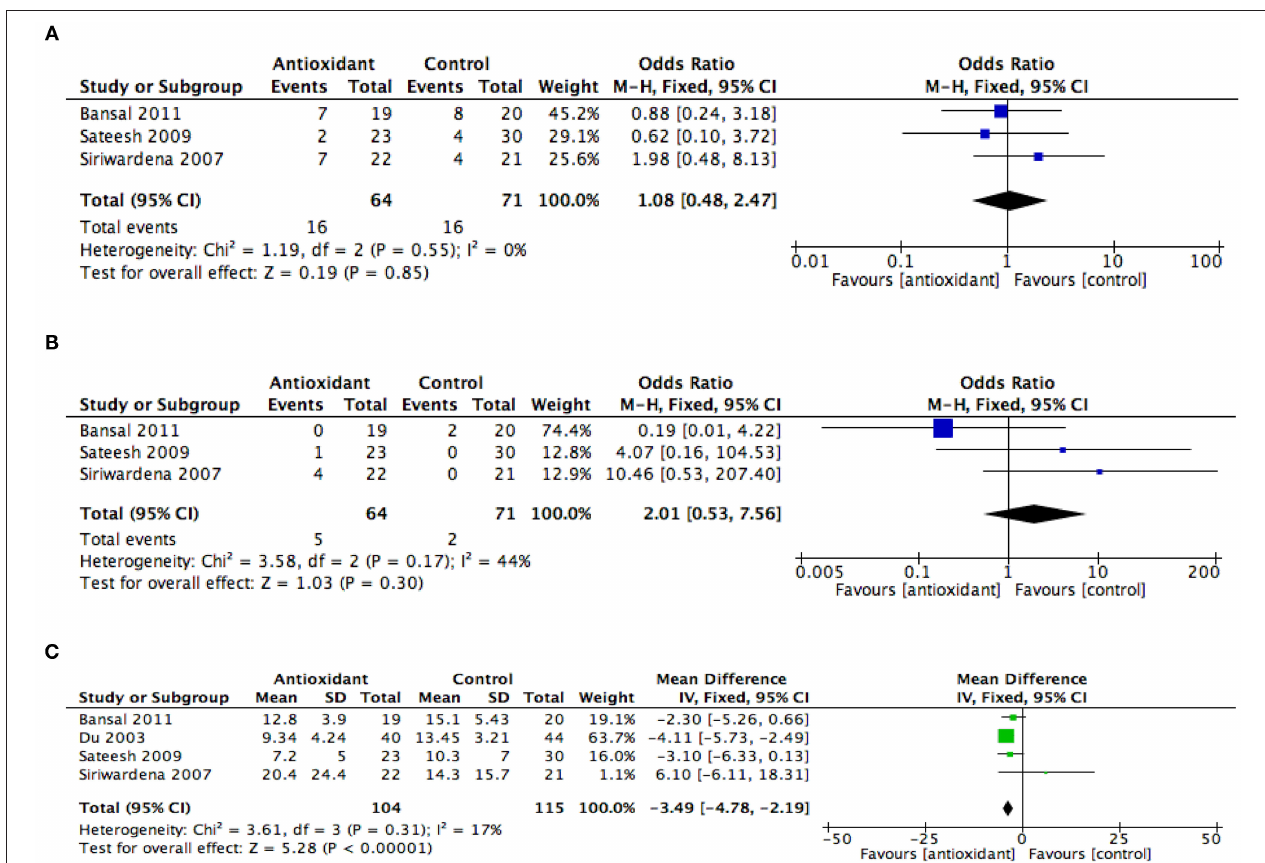
FIGURE 3 | Summary meta-analysis of studies reporting effects of ascorbic acid administration on clinical outcomes in patients with AP compared with controls: (A) organ failure, (B) mortality, and (C) length of hospital stay. M-H, Mantel–Haenszel; SD, standard deviation; Std., mean difference, standardized mean difference; IV, inverse variance; CI, confidence interval; Tau 2 , tau-square statistic; Chi 2 , chi-square statistic; df, degrees of freedom; I 2 , I-square heterogeneity statistic; Z, Z statistic.